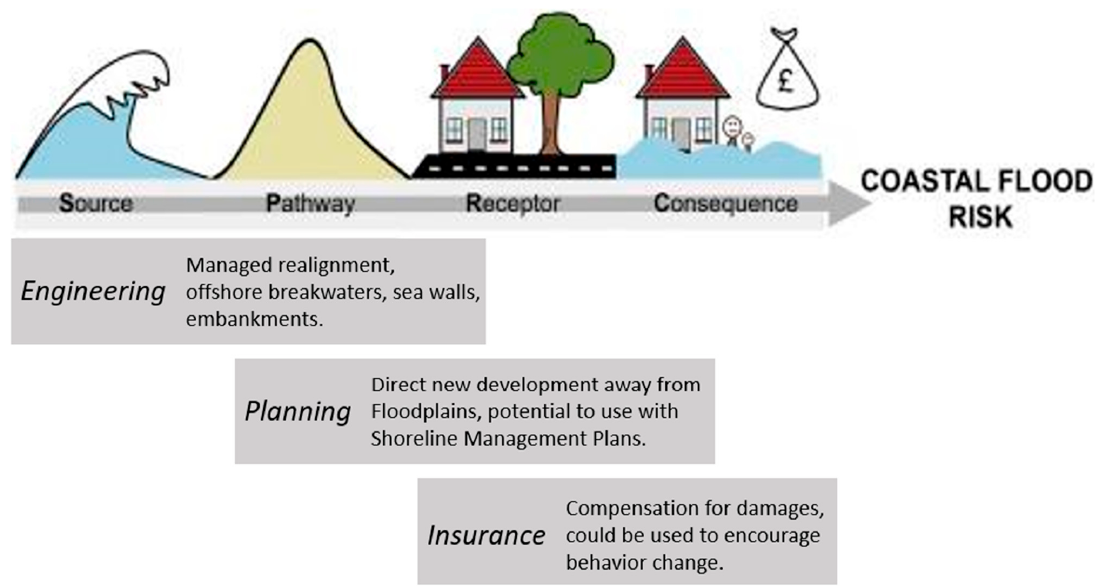
Figure A1. Conceptual model of coastal flooding risk to buildings [19].